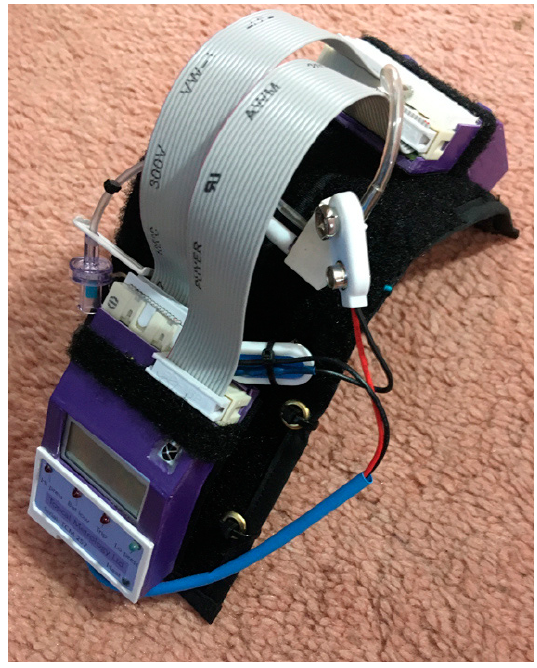
Figure 2. Remote controlled cat thermal band with cover removed.